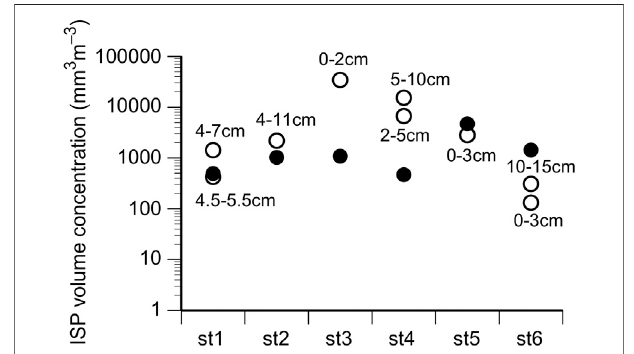
FIGURE 3 | Mass concentrations of ISP in snowpack (solid circle) and the glacial ice (open circle) at site 1 – 6.